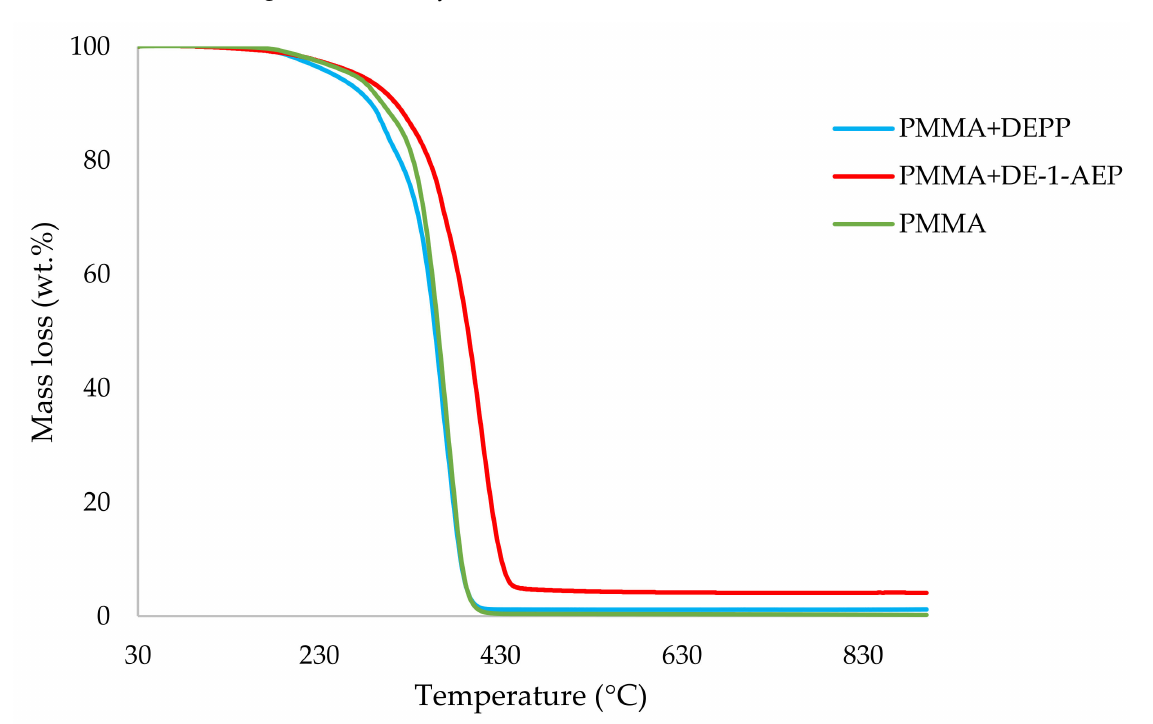
Figure 3. An overlay of the TGA curves of PMMA-based materials with reactives, at 10 ◦ C min − 1 .